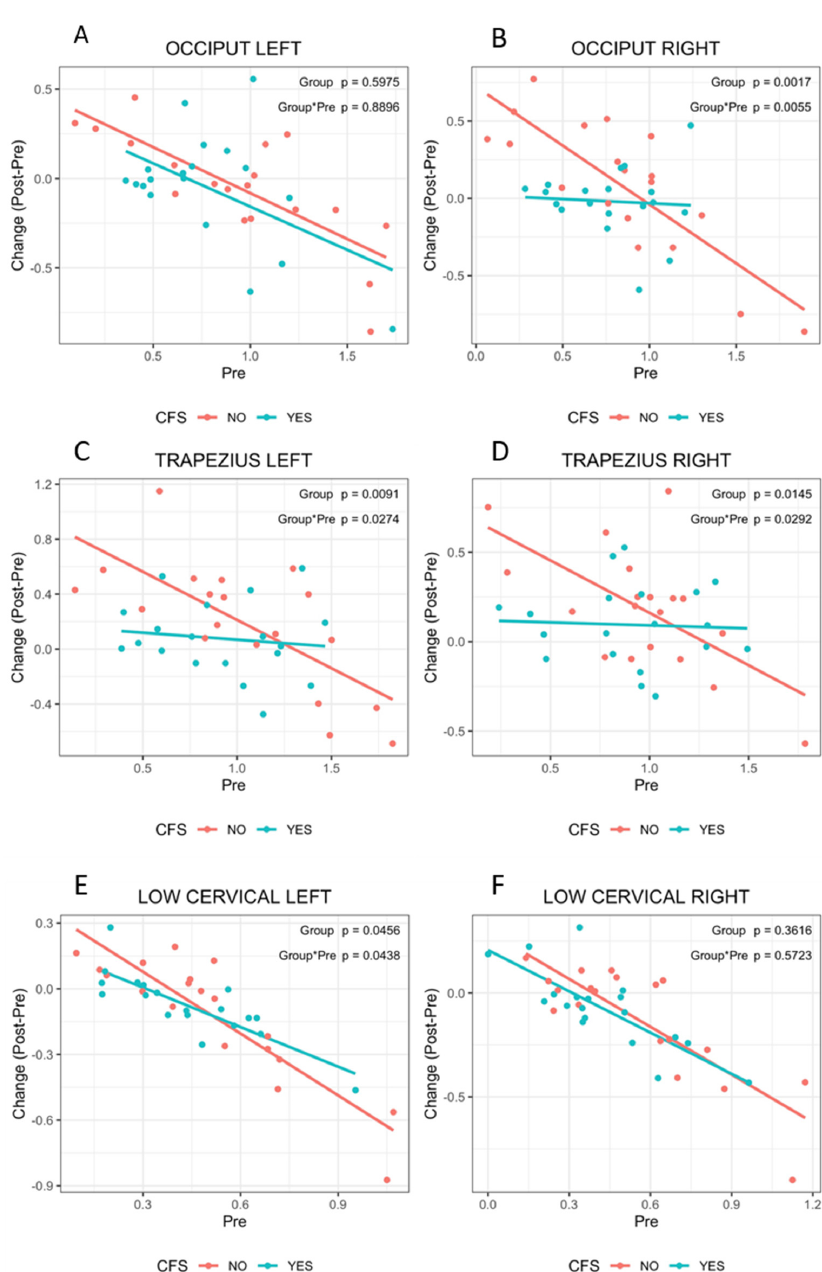
Figure 3. Linear dependence of PPT baseline scores (Pre) with MT therapy response (Change: Post–Pre) in patients presenting FM with or without comorbid ME/CFS. The plots show the inverse correlation between pre-treatment PPT values and symptom improvement, measured as the acquired resistance to pressure-induced pain for the tenderpoints at the Occiput left side of the body ( A ), or the right ( B ); and the same type of correlation for the tenderpoint at the left Trapezius ( C ) or its corresponding right PPT ( D ), and for the left Low cervical ( E ) or Low cervical right ( F ). Linear adjustments in the FM only subgroup are shown in red color, while those for the FM patients that present with ME/CFS comorbidity are shown in green. p values of the differences between FM only and FM with ME/CFS are shown.